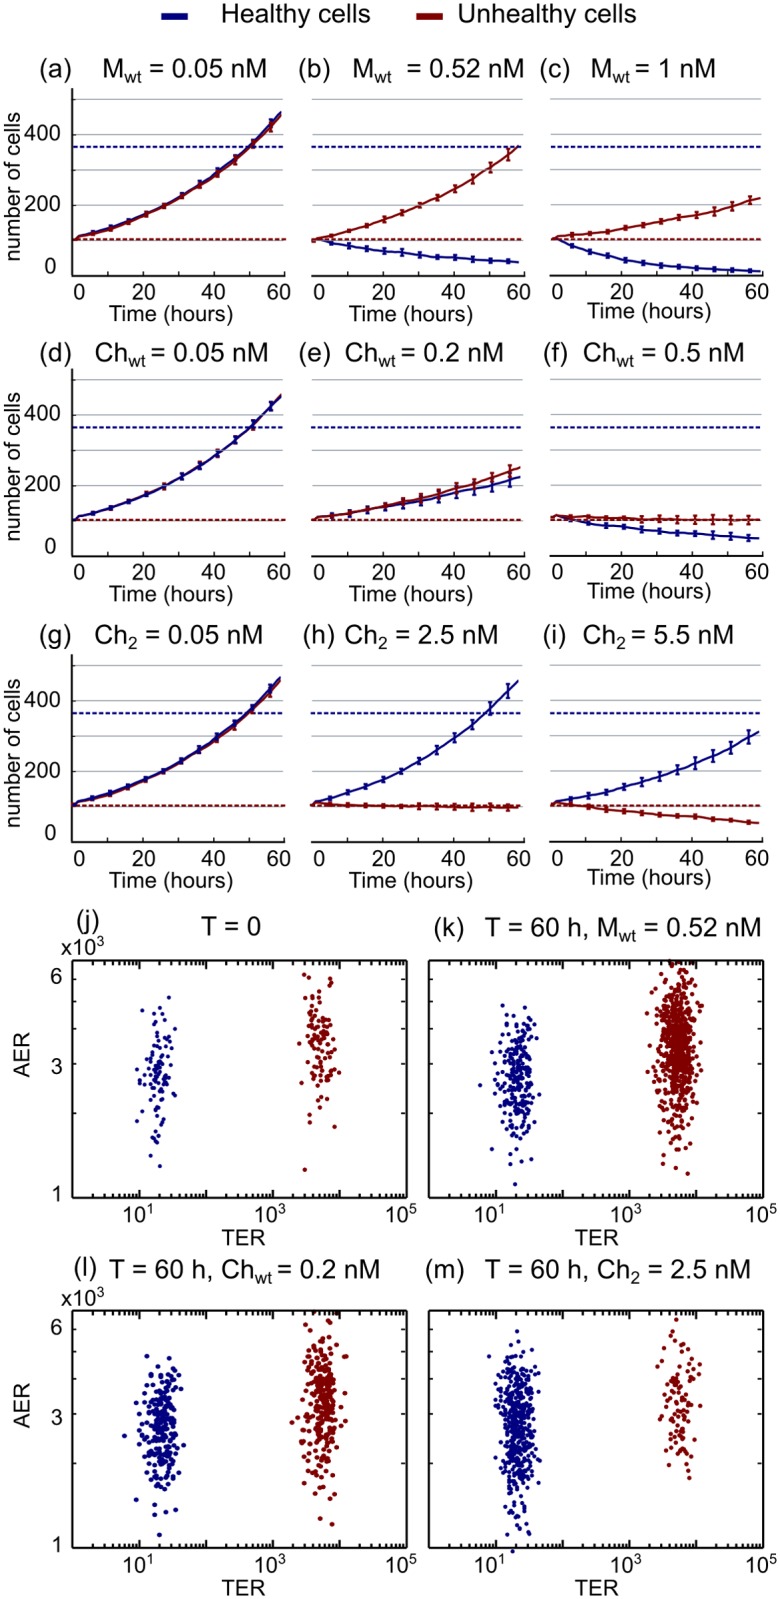
Dynamics of the cell populations after individual drug treatment.(A–C) Numerical solution of the model equations showing the time evolution of healthy (blue line) and unhealthy (red line) cells after treatment with low, intermediate and high concentrations of the M
wt monomer. (D–F) Time evolution after treatment with different concentrations of Ch
wt. (G–I) Time evolution after treatment with different concentrations of Ch
2, which at intermediate values is able to achieve the threshold of 80% survival of healthy cells, while the unhealthy cells are maintained. Solid line and error bars correspond to the average and standard deviation of 10 independent runs of the model. (J–M) Distribution of the AER and TER receptors for the two cell populations at (J) initial conditions, and after 60 hours of treatment with (K) M
wt = 0.52 nM, (E) Ch
wt = 0.2 nM and (M) Ch
2 = 2.5 nM (i.e, same concentrations of Fig. 2B,E,H, respectively) Each dot corresponds to a cell in the population. Notice that M
wt treatment affects mainly the unhealthy cells (blue line, B,C), while Ch
2 treatment shows a greater effect on the unhealthy population (red line, H–I).